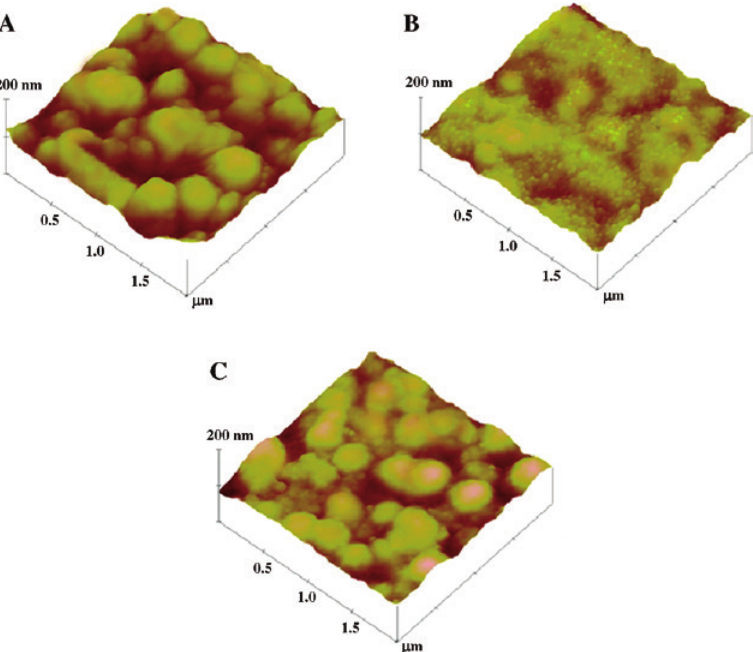
Figure 3: Atomic force microscopy (AFM) images of Ni-TiN composite coatings deposited with different magnetic intensities: (A) 0 T, (B) 0.3 T and (C) 0.6 T.